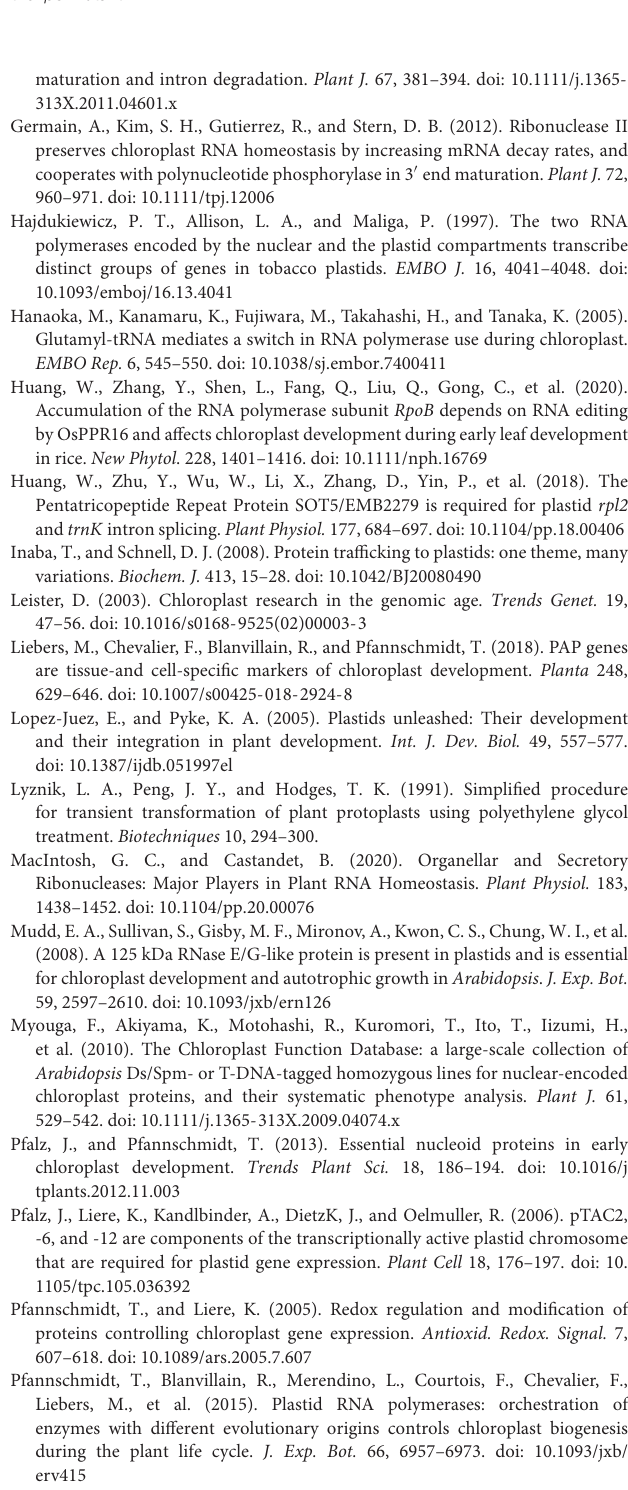
Supplementary Figure 2 | Protein alignment analysis between RP8 and RP8-like Protein (AT1G36320). Supplementary Figure 3 | Different stages of development and tissue expression of the RP8 gene, according to publicly available Affymetrix GeneChip microarray data.